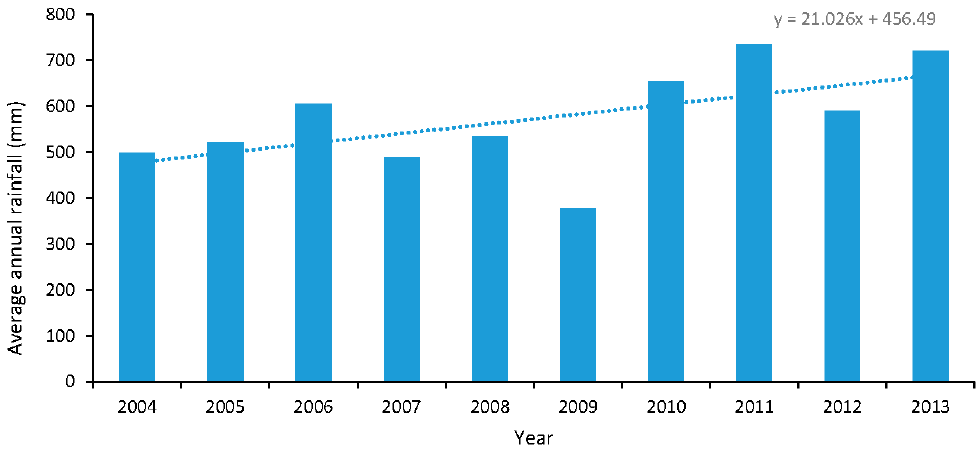
Figure 2. Rainfall hyetograph for Rajasthan state from 2004 to 2013.